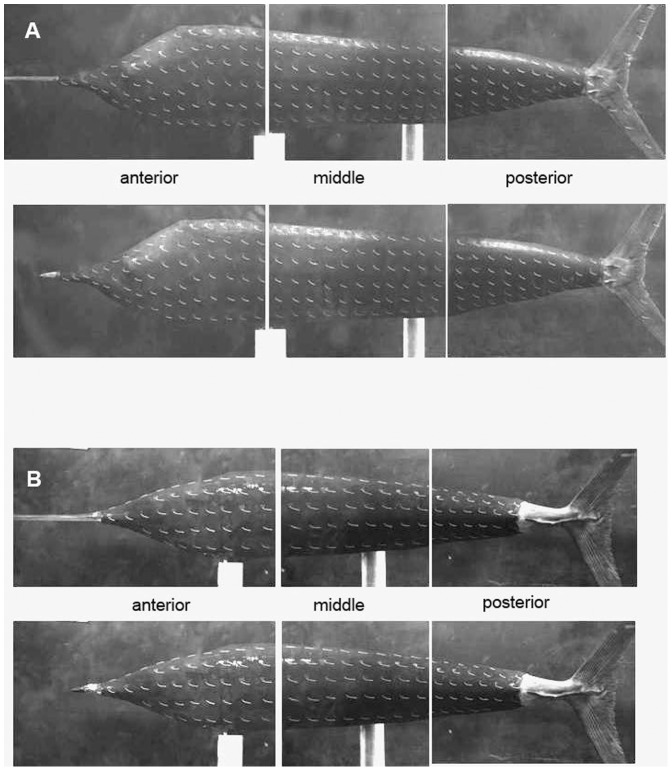
Tuft visualizations on the body surface.In both A sailfish and B swordfish, the upper and lower figures correspond to the fish with the original and shorter bills, respectively. Here, the body of each fish is wrapped by a thin tape and then coated in black paint for better visualization.